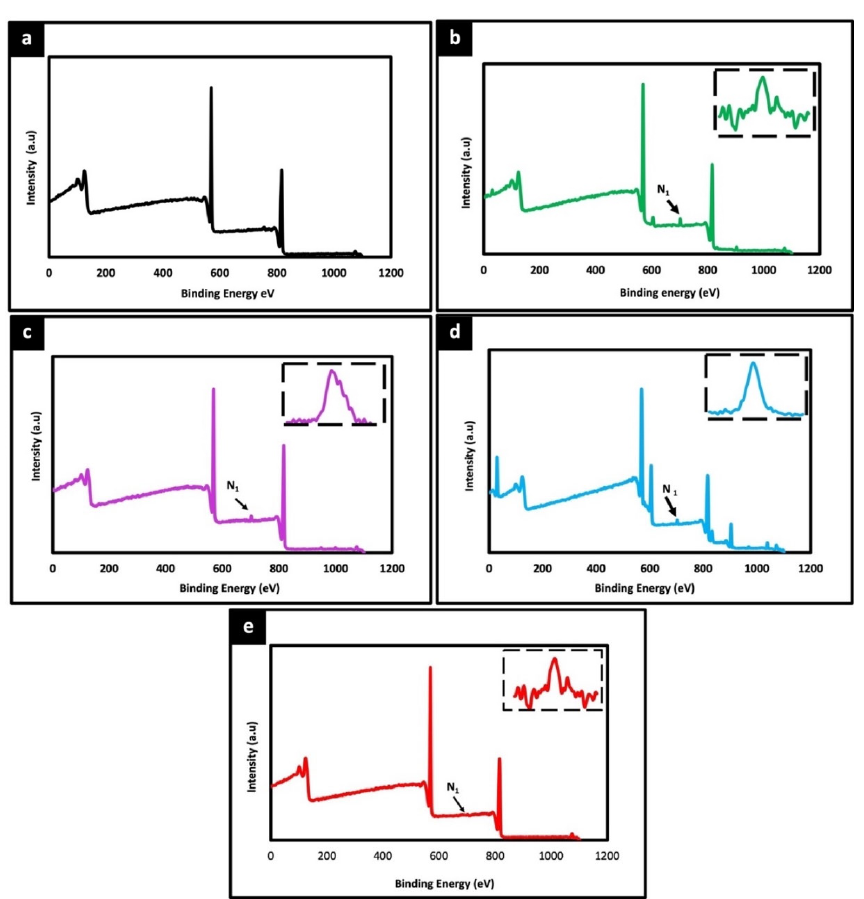
Figure 4. X ‐ ray photoelectron spectroscopy (XPS) wide spectra of unmodified PLLA scaffold ( a ) and different ECM protein surface functionalized PLLA scaffolds ( b ) Collagen, ( c ) Gelatin ( d ) Fibronectin ( e ) Poly L Lysine. The peaks at 285 eV, 532 eV corresponds to C1s and O1s, respectively. A prominent peak at 400 eV for all surface functionalized scaffolds (arrow) represents N1s attributing to successful functionalization of protein on the fiber scaffolds. Inset spectra represent the corresponding nitrogen peak.